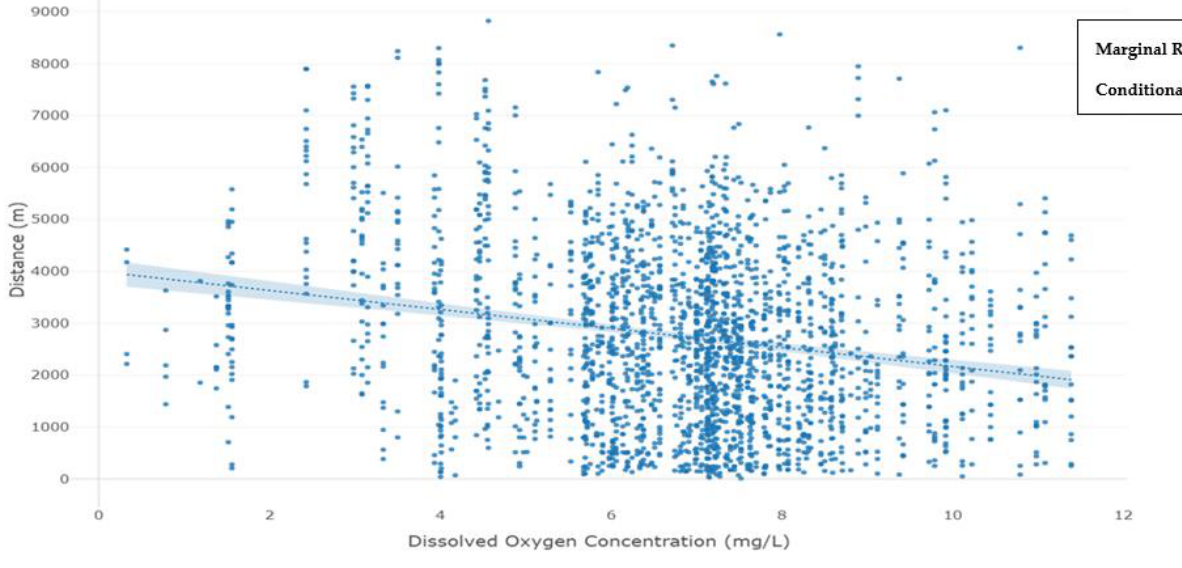
Figure A3. Linear model of daily distance traveled as a function of dissolved oxygen concentration